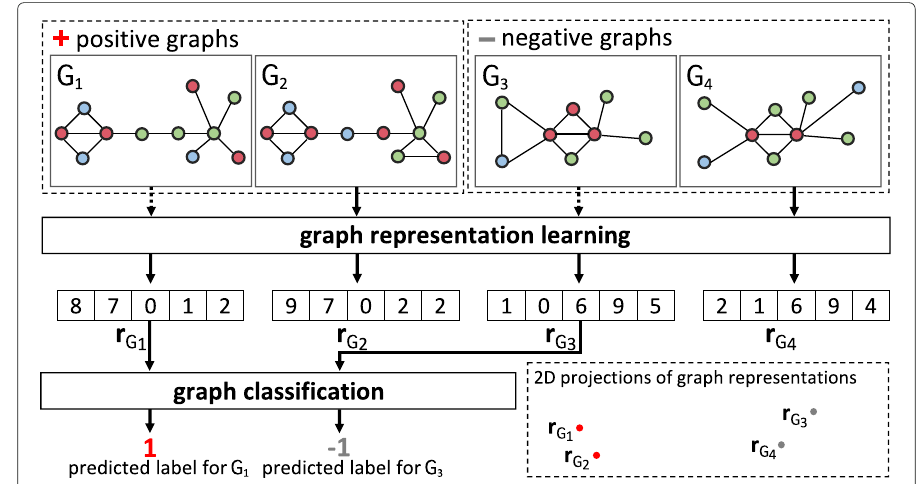
Fig. 1 An example of the representation learning problem for graph classification. Here, the graph representation model is trained using the graphs attached to solid lines ( G 2 and G 4 ). The corresponding representations (for G 2 and G 4 ) are then used to train the classifier. The trained model can then be used to generate representations for unseen samples, shown with dashed lines here ( G 1 and G 3